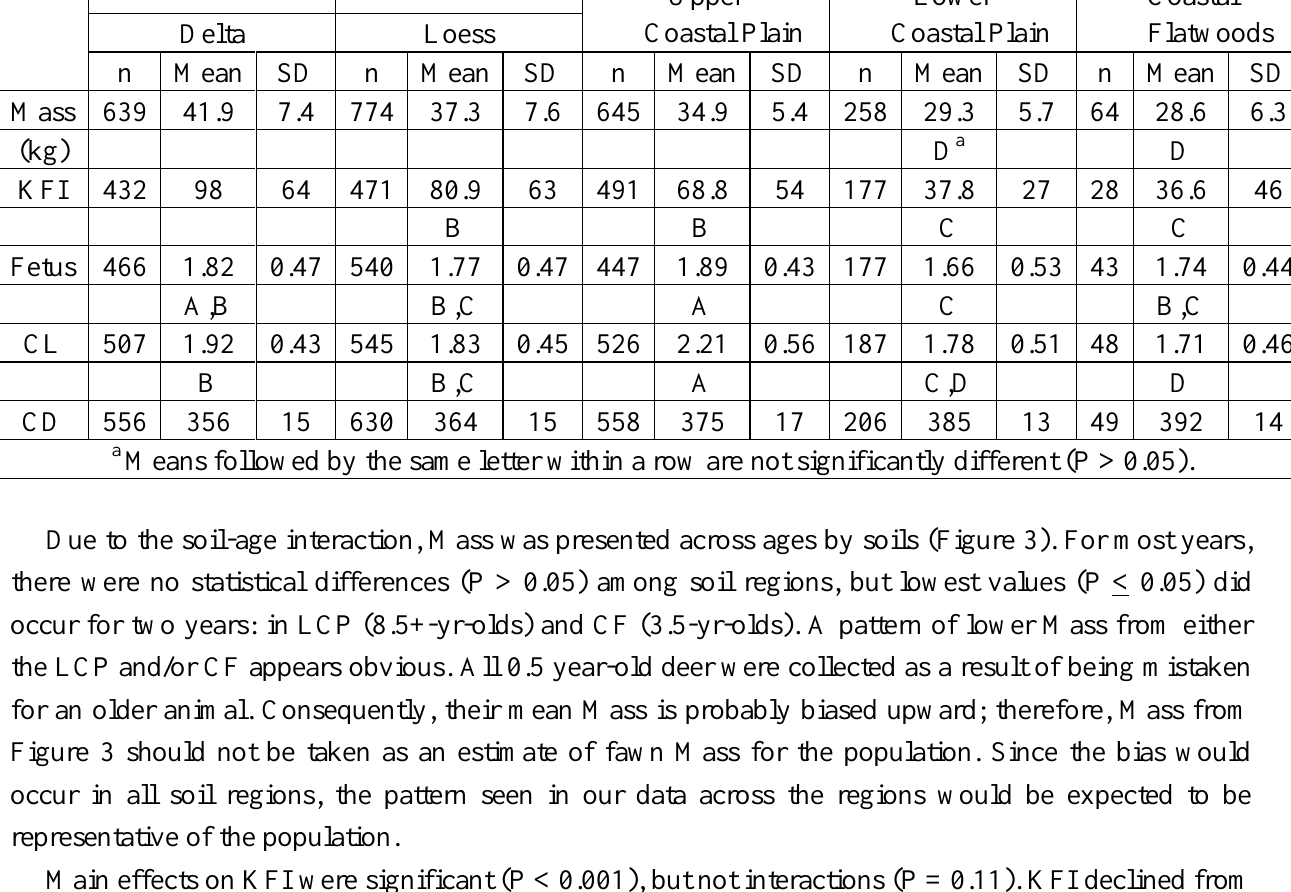
Upper Lower Coastal Plain Coastal Plain